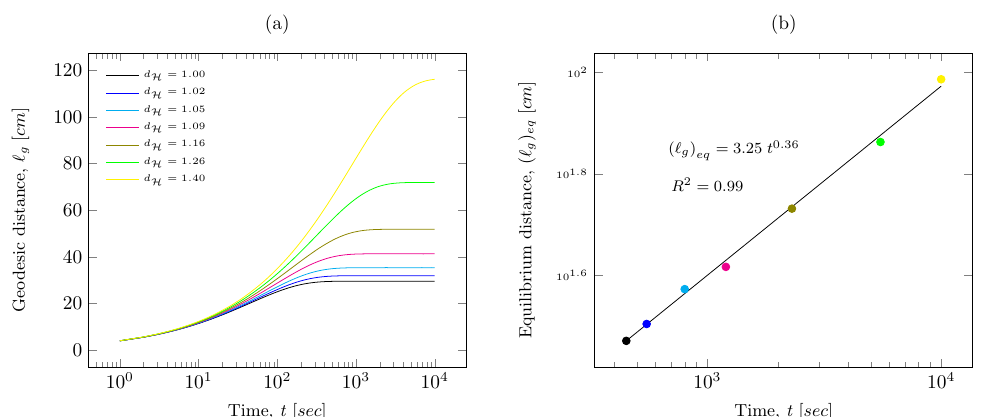
Figure 5. Geodesic distances for the second stage of imbibition, ( a ) as a function of Hausdorff dimension and ( b ) equilibrium